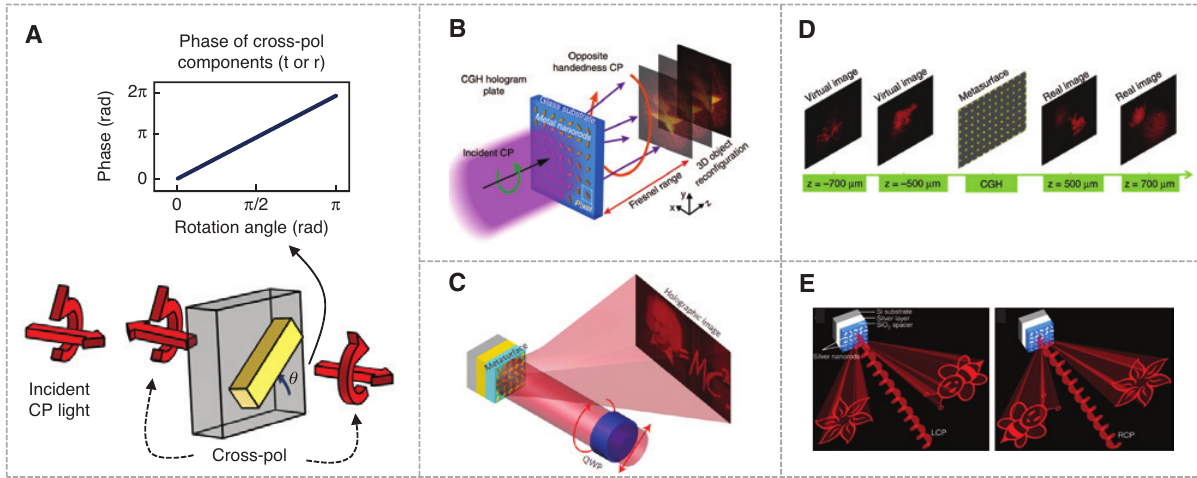
Figure 1: Phase modulation methods with meta-atoms and metahologram examples. (A) Schematic diagram showing the mechanism of the PB phase method (bottom) and the graph of resultant phase value of the scattered cross-polarized component. (B) Transmissive-type three-dimensional optical holography by plasmonic metasurface [29]. (C) Reflective- type hologram reaching 80% efficiency with plasmonic metasurface [49]. (D) Holographic multiplexing via plasmonic metasurfaces [50]. (E) Reflective-type helicity multiplexed meta-hologram